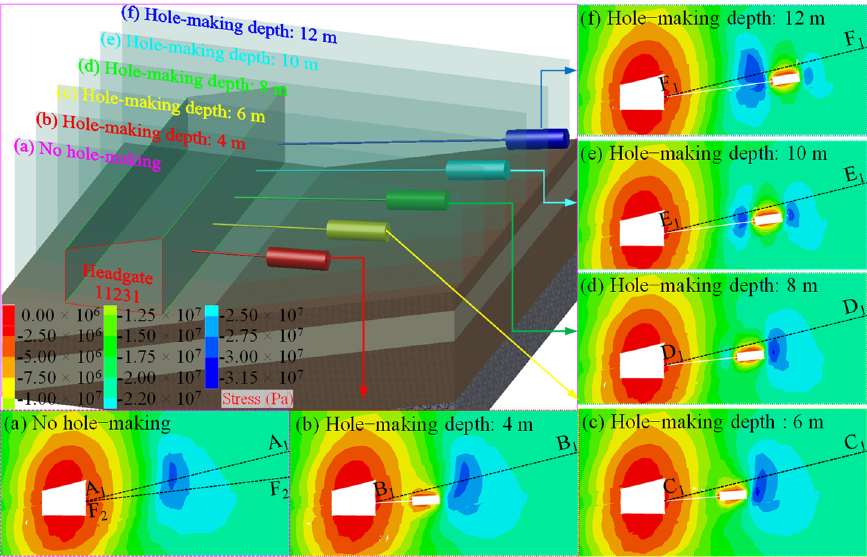
Figure 9. Layout scheme under different hole-making depths and distribution nephogram of verti- cal stress.